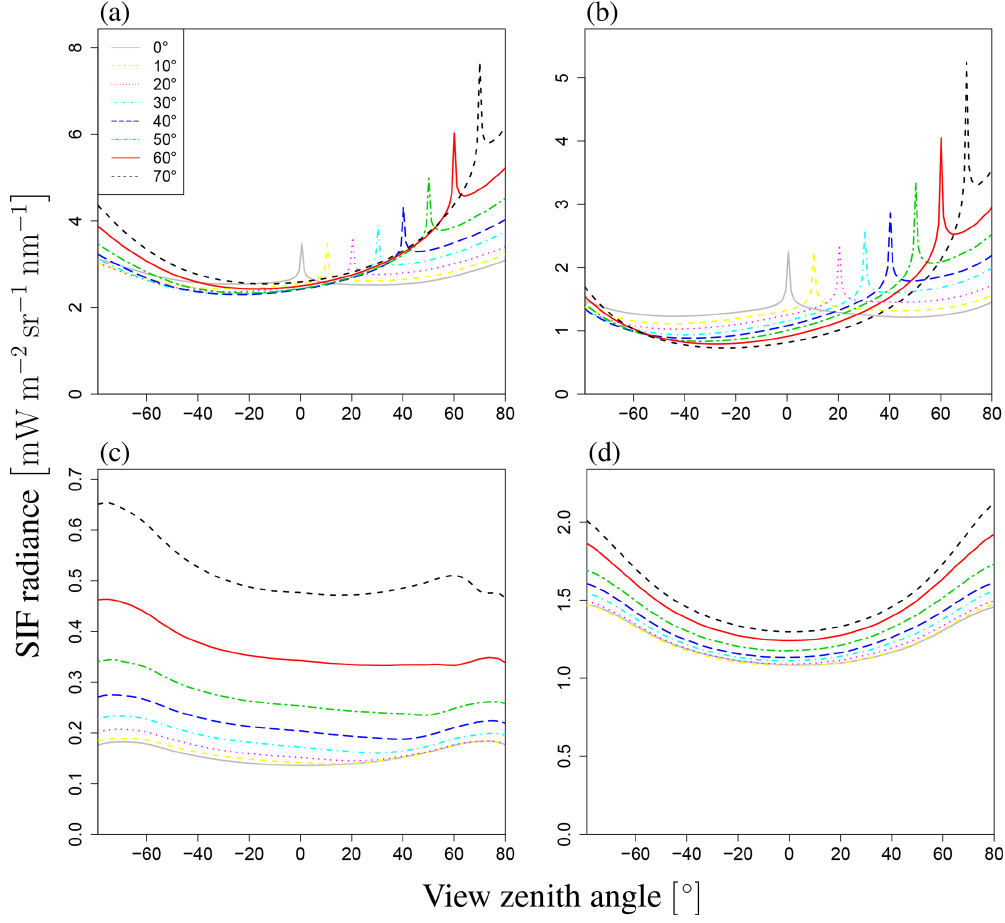
Figure 11. Angular dependence of SIF. This figure shows total radiance I (a) , direct radiance from sunlit leaves I dir_sun (b) , direct radiance from shaded leaves I dir_shade (c) , and radiance after multiple scatterings I ms_sun + I ms_shade (d) at LAI of 3.0. Each line represents a different SZA (0–70 ◦ ). Negative values of SZA represent the backward direction, and positive values represent the forward direction on the principal plane. The angular dependency varies greatly among these